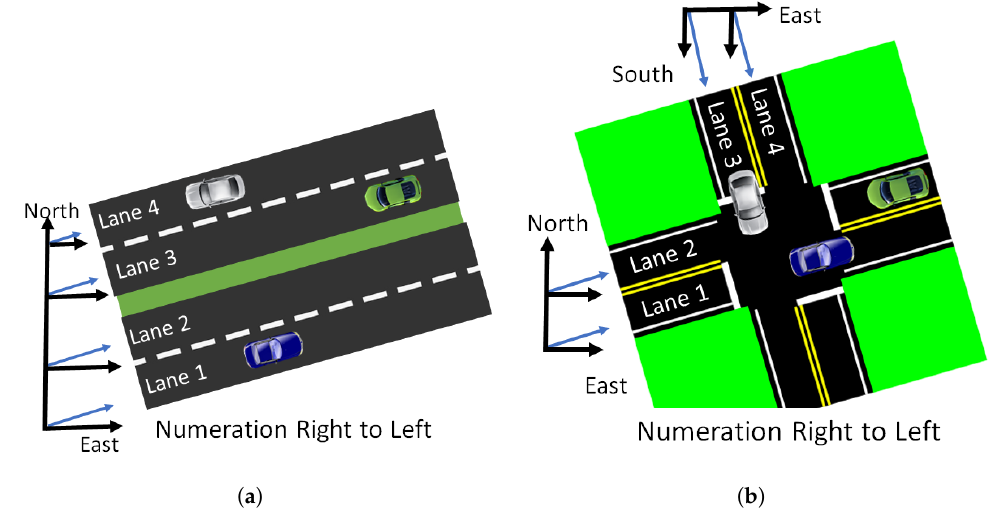
Figure 7. Examples of lane numbering for different road configurations. ( a ) Highway lane numbering. ( b ) Intersection lane